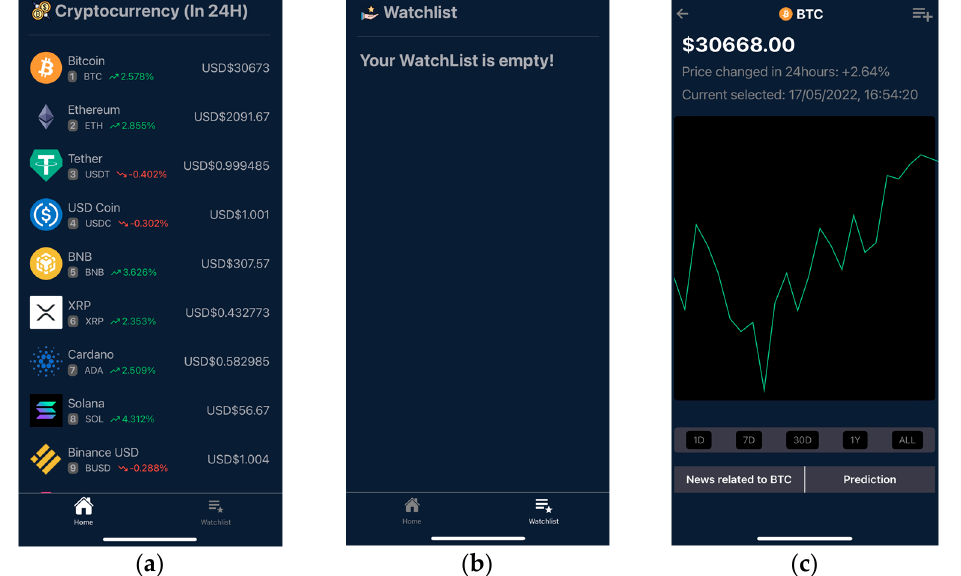
Figure 10. Prototype screen dump of the ( a ) homepage, ( b ) watchlist, and ( c ) detail page.